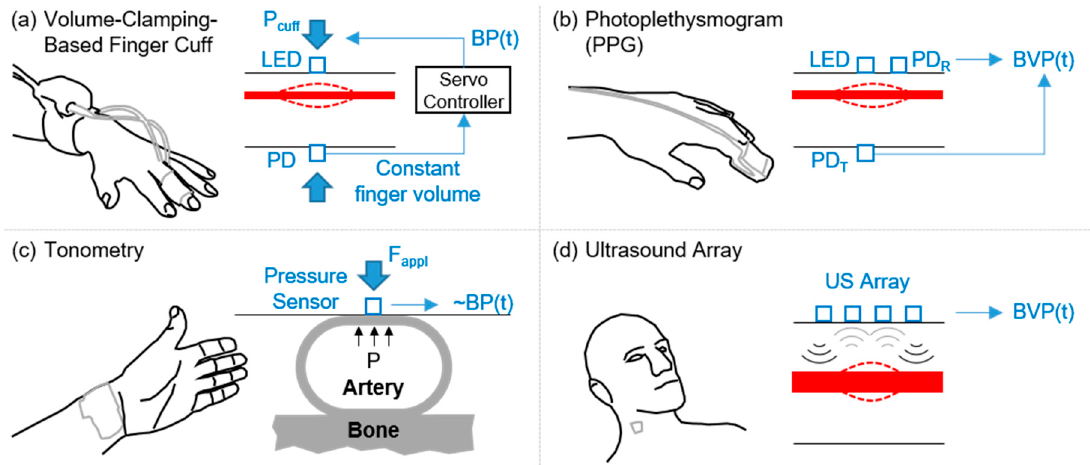
Figure 5. Illustration of different waveforms capture techniques that can provide a blood pressure (BP(t)) or blood volume pulse (BVP(t)) signal. ( a ) Volume-clamping based finger-cuff BP measurement (i.e., Finapres). ( b ) Photoplethysmography (PPG) based blood volume pulse measurement. ( c ) Tonometry based arterial pulse measurement. Image created based on Lee and Nam [75]. ( d ) Ultrasound array based arterial pulse measurement. Image created based on Wang and Xu [76].